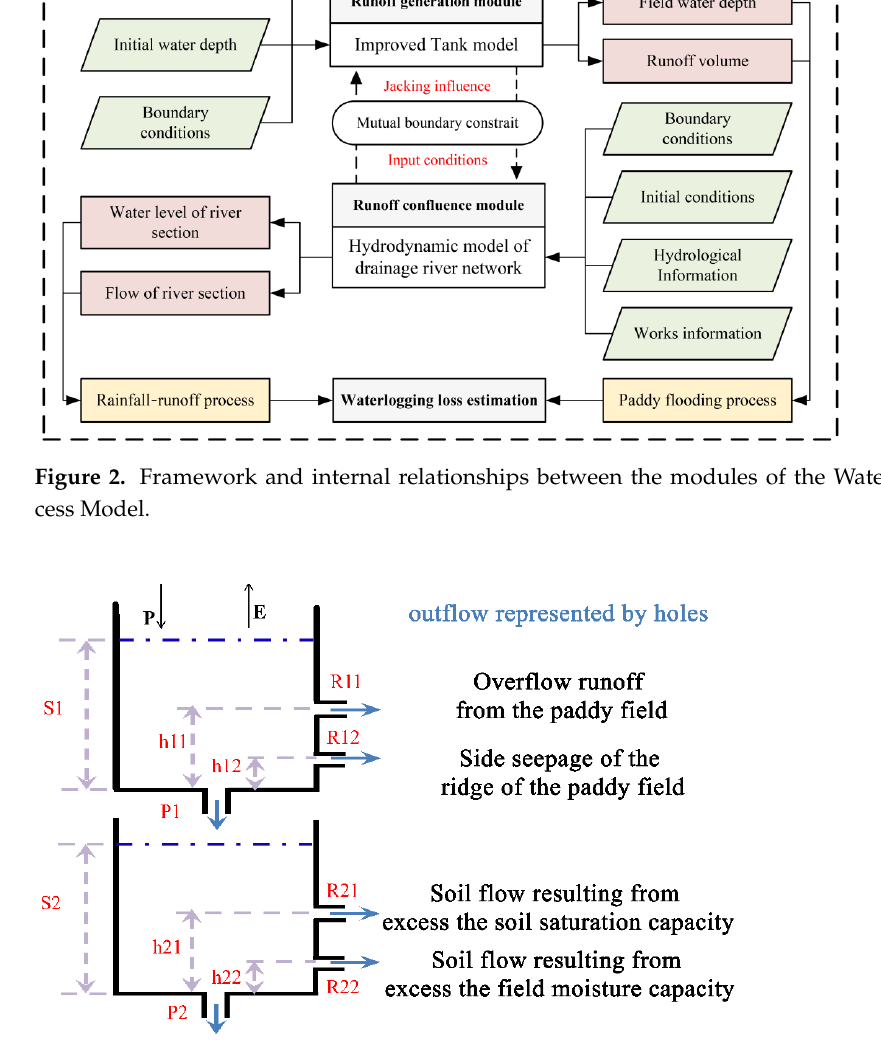
Figure 3. The structure and meaning of the two-layer tank model.